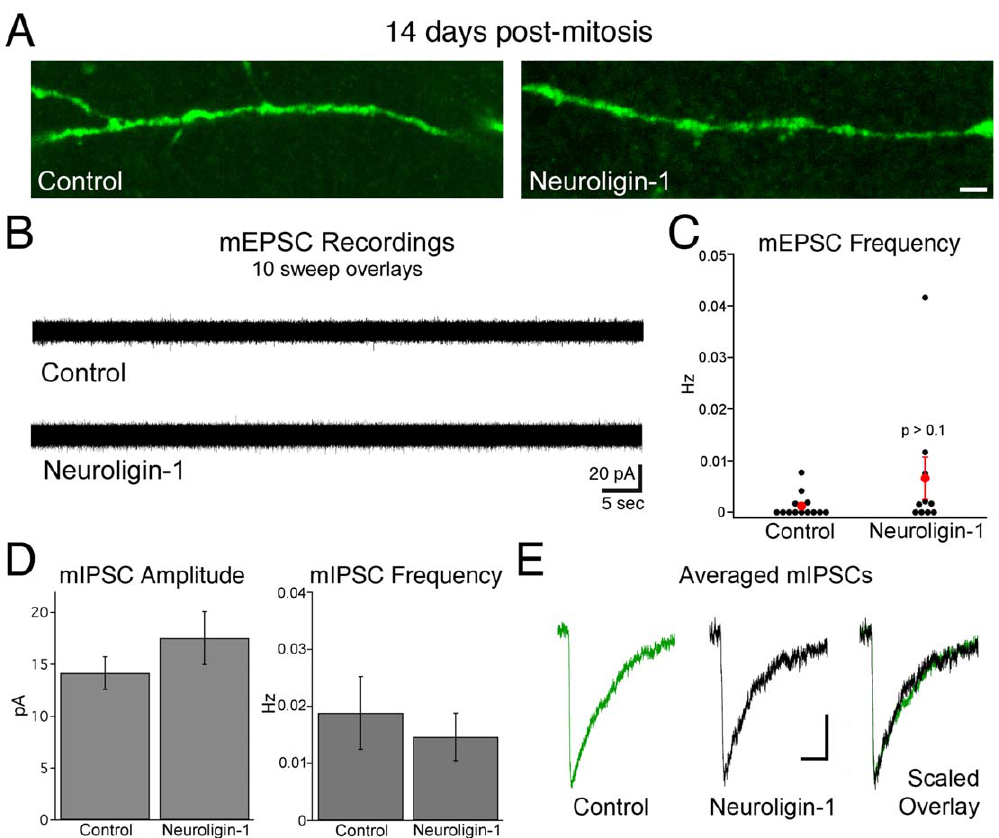
Figure 5. Neuroligin-1 overexpression does not accelerate excitatory synapse formation. A. Dendritic segments (inner molecular layer) of control and neuroligin-1 overexpressing granule cells rarely contain spines at 14 days post-mitosis. Scale bar: 2 m m. B. Sample mEPSC traces from control (GFP only infected) or neuroligin-1 overexpressing cells showing a lack of excitatory currents in 14-day-old cells. For each example, 10 consecutive sweeps (400 continuous seconds each) are overlaid. Scale bars: 20 pA, 5 sec. C. mEPSC frequencies from 14 day-old cells. The event frequency is shown for each cell, with mean data in red. The mode frequency in each group is zero events, and averaged frequencies are not significantly different (control, n=13 cells; NLG-1, n=10 cells, p . 0.1). D. mIPSC recordings show no change in mIPSC amplitude or frequency in 14- day-old neuroligin-1 overexpressing cells (control, n=10 cells; NLG-1, n=8 cells; p . 0.2 for each). E. Representative averaged mIPSCs from single cells, as well as a peak-scaled overlay, demonstrate no difference in mIPSC kinetics between conditions. Scale bars: 50 pA, 50 ms.